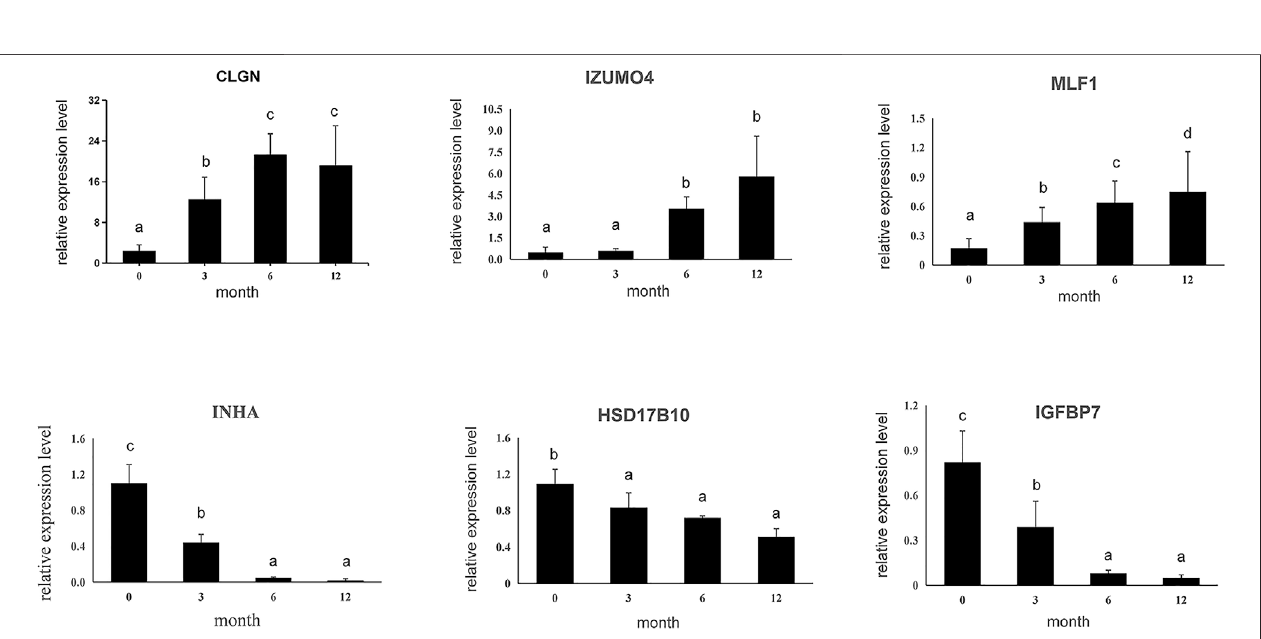
Frontiers in Genetics |